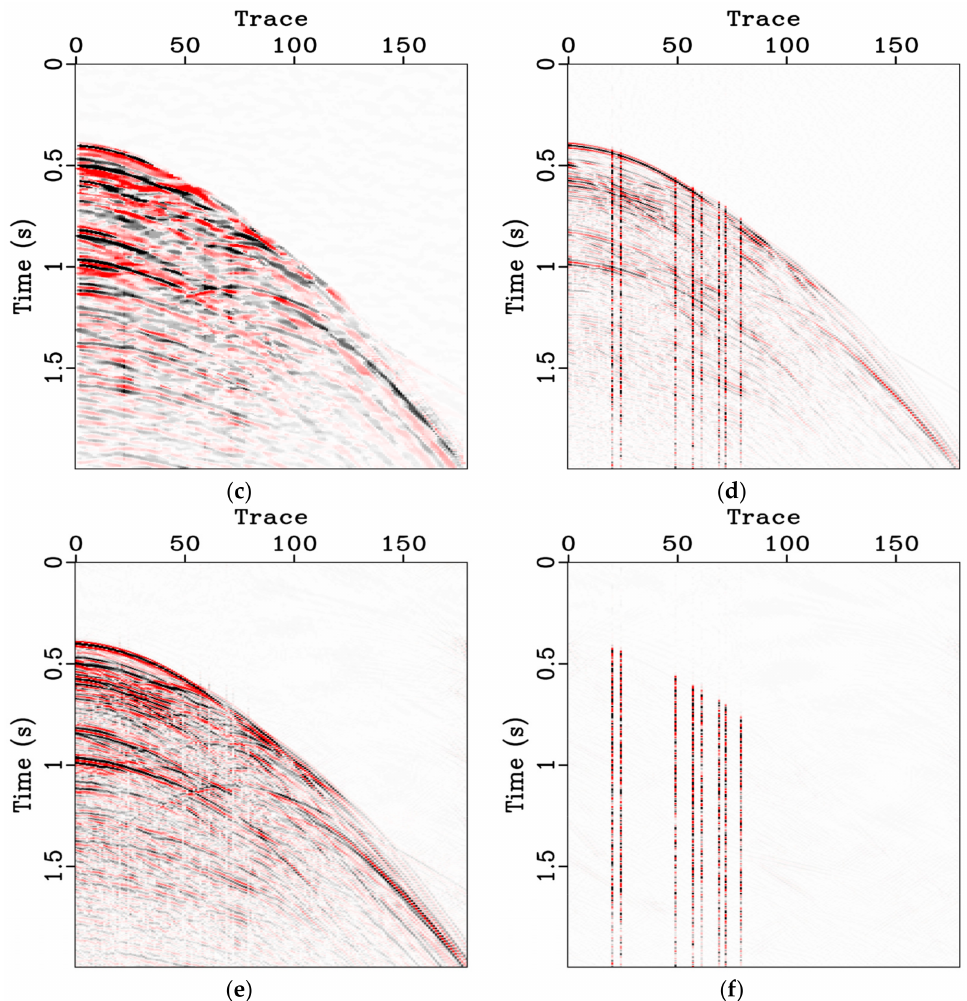
Figure 11. Marine data comparison of denoising performance. ( a ) Noisy data with outlier noise. (SNR = − 2.09 dB; PSNR = 9.32 dB). ( b ) Removed traces with outlier noise. ( c ) The denoised results of median filtering (SNR = 6.14 dB, PSNR = 11.32 dB). ( d ) Removed noise by median filtering. ( e ) The reconstructed results of ( b ) (SNR = 7.20 dB; PSNR = 20.61 dB). ( f ) Removed noise by